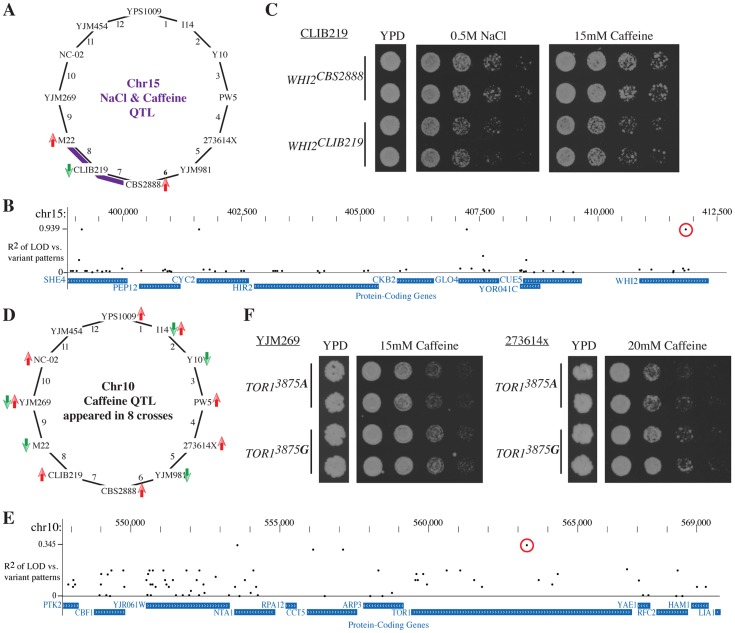
Leveraging the Round Robin design to identify causative variants.(A) A QTL on chromsome 15 affects salt and caffeine resistance in crosses 7 and 8 (with smaller effects in other crosses). The CLIB219 is shared between the two crosses and in both cases it contributes the allele is selected against, suggesting that the causative variant is private to CLIB219. (B) We determined the association of coding variants within this QTL interval with the observed pattern of LOD scores. The highest association scores were exhibited by four variants private to CLIB219; one a frame-shift mutation in WHI2. (C) Allele replacements of WHI2 in the CLIB219 strain background. The CLIB219-specific frame shift mutation resulted in decreased growth in the presence of both high salt and caffeine. (D) Identification of a quantitative trait nucleotide (QTN) within the caffeine resistance QTL on chromosome 10. The QTL was identified in eight crosses and is multi-allelic as specific alleles were beneficial or deleterious depending on a particular cross. (E) Measuring the association of variants and LOD scores confirmed that no single variant could explain the observed pattern of QTL and indicated a TOR1 SNP (3875 G -> A) as a QTN (red circle). (F) Introduction of the TOR13875
A variant into two strain backgrounds, YJM269 and 273614x, reduced resistance to caffeine. For each allele replacements two independent transformants are shown.